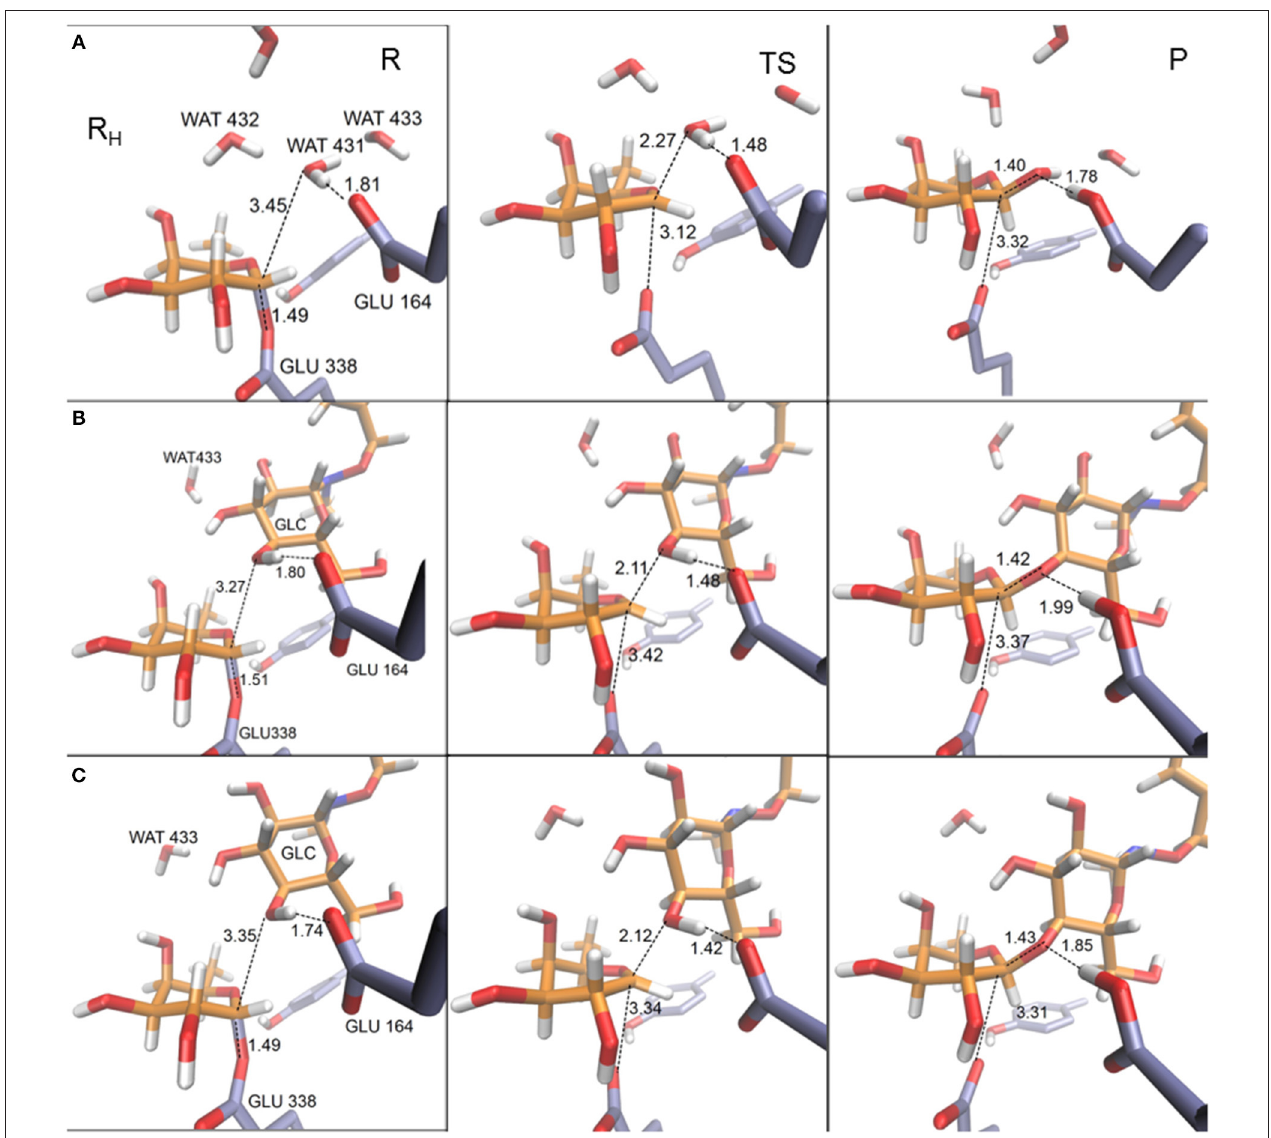
FIGURE 6 | Representative structures for reactant (R), transition state (TS), and product (P) for hydrolysis (A) and transglycosylation reactions (frame T I (B) and frame T II (C) . The depicted geometries were calculated within the QM(large)/MM partition and with the QM region described at the PBE0/TZVP level. Distances are in Å. = − 0.87 Å) than the transglycosylation one (RC T = − 1.04